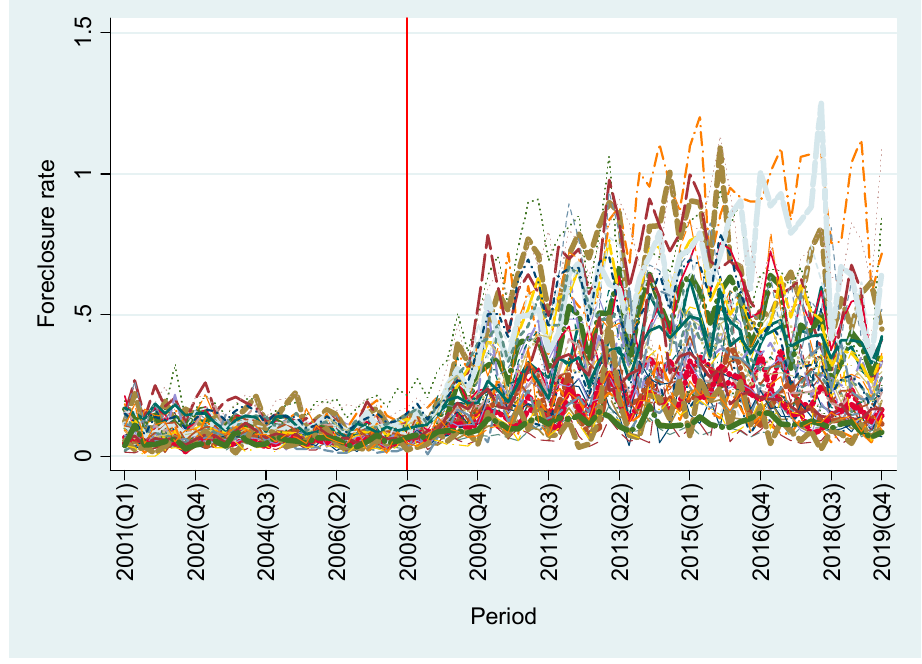
Figure 2. Provinces’ foreclosure rate, 2001 (Q1)–2019 (Q4). The vertical line indicates the start of the global financial crisis in 2008(Q1).